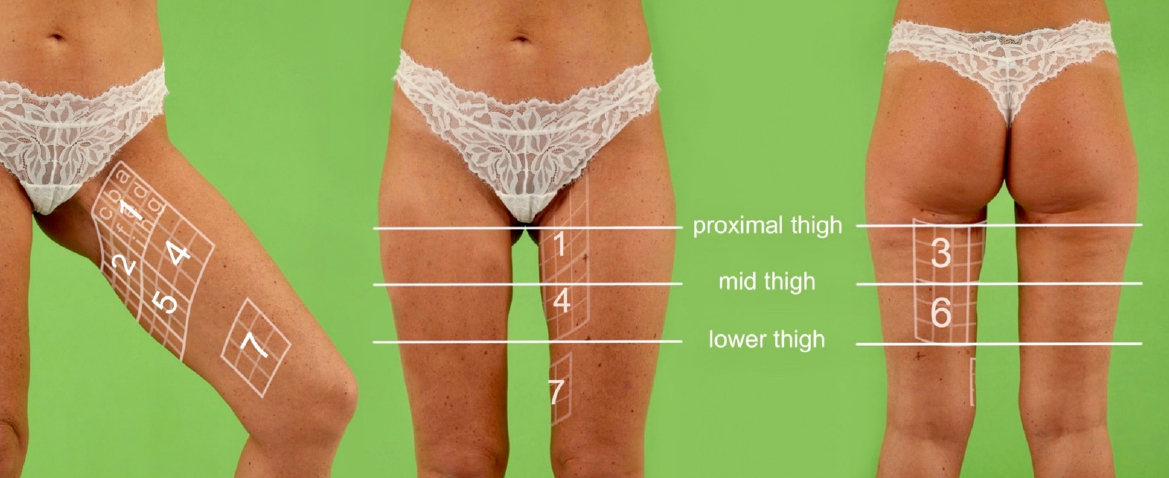
Figure 1. Normal weight female patient (47 years, BMI 22.7 kg/m 2 ) with bilateral transverse musculocutaneous gracilis (TMG) flap breast reconstruction. Digital markings indicating the grid for sensation measurements on the donor thigh and the proximal thigh, the mid-thigh and the lower thigh, where measurement of the thigh circumference was conducted. The grid for sensation measurements was divided in euals quadrants (1–7). Each quadrant was subdivided into nine smaller squares (a–i).